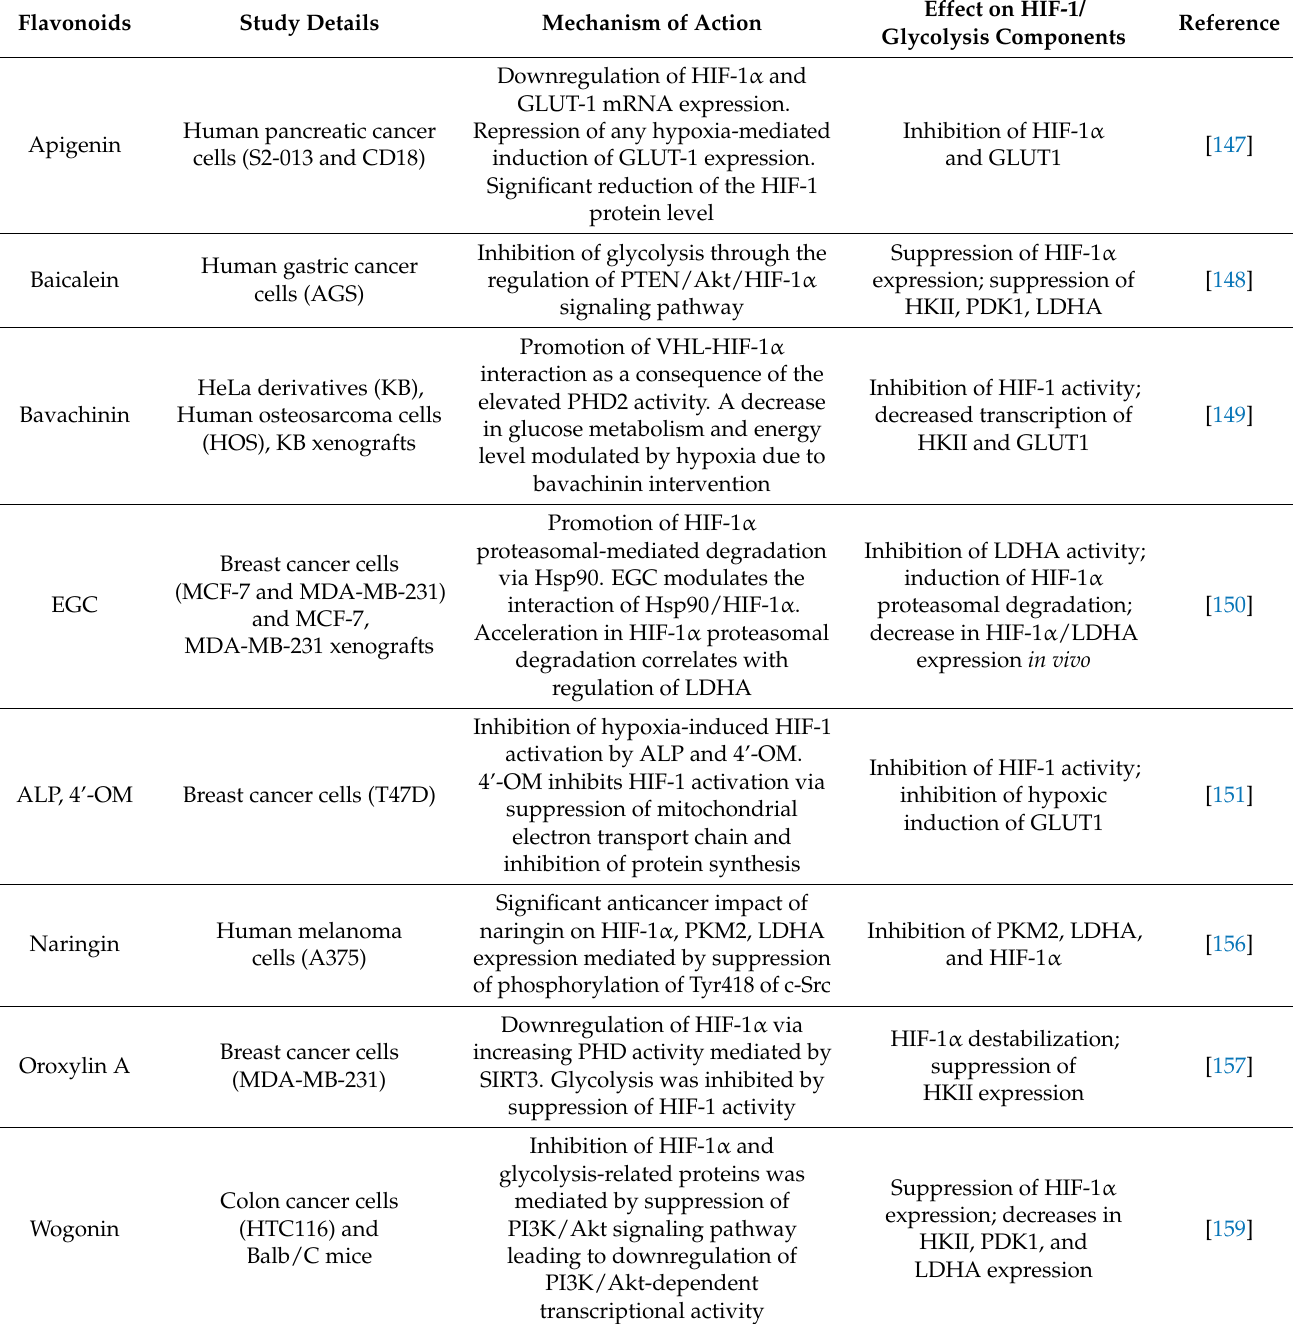
Table 3. Flavonoids targeting HIF-1-associated components contributing to the Warburg